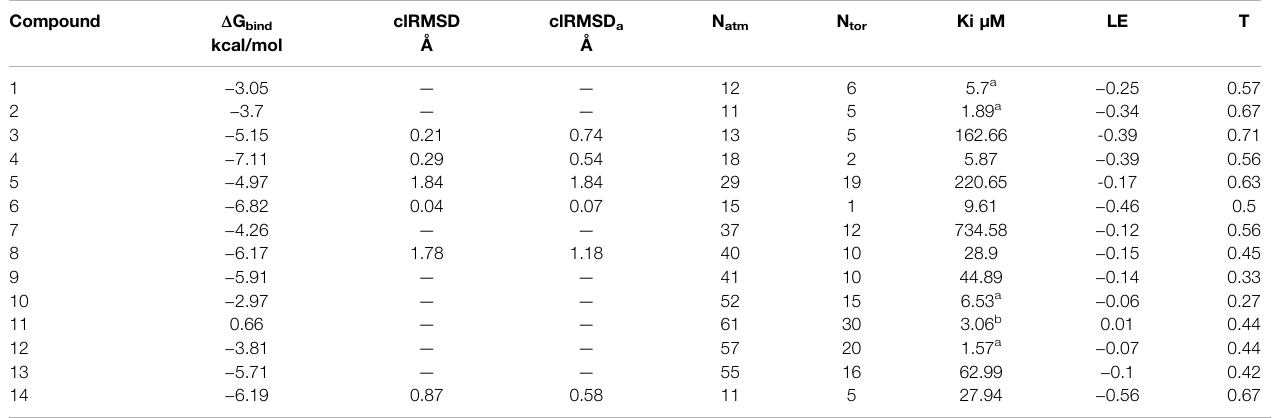
TABLE 2 | Summary of AutoDock molecular docking results for drugs (n (cid:1) 13), containing propanesulfonic scaffold of TRA. Compound Δ G bind kcal/mol